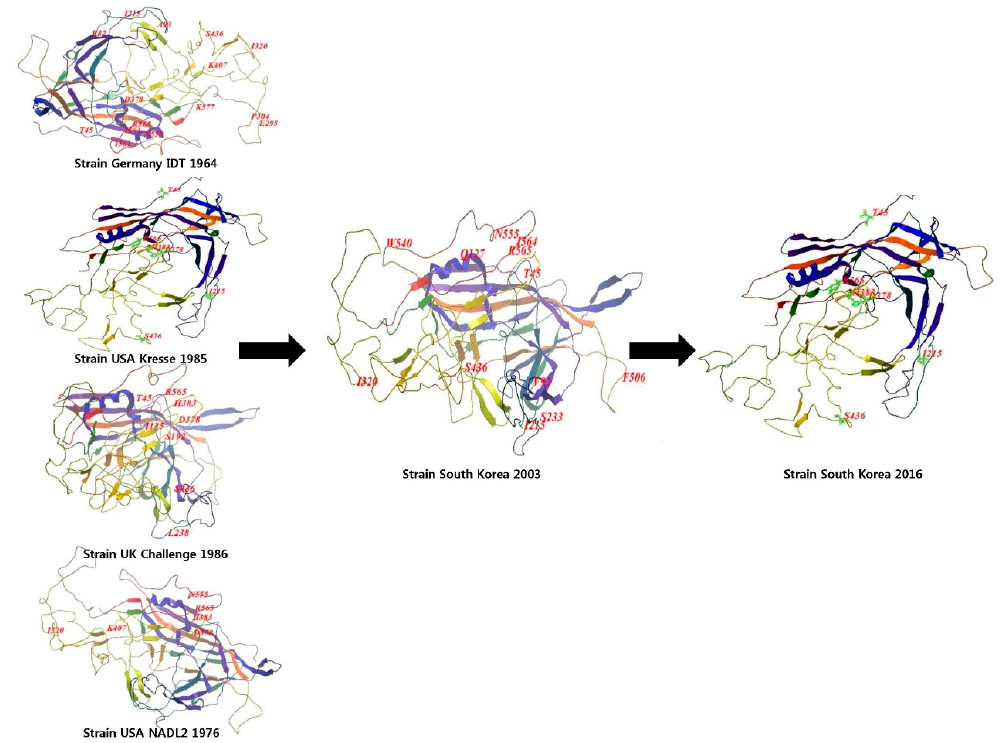
Figure 5. Cartoon structure of NADL-2, Kresse, Challenge, Germany Vaccine Tornau, South Korea 2003 (accession number: AY390557.1), and T142_South Korea strains drawn chronologically with Mol